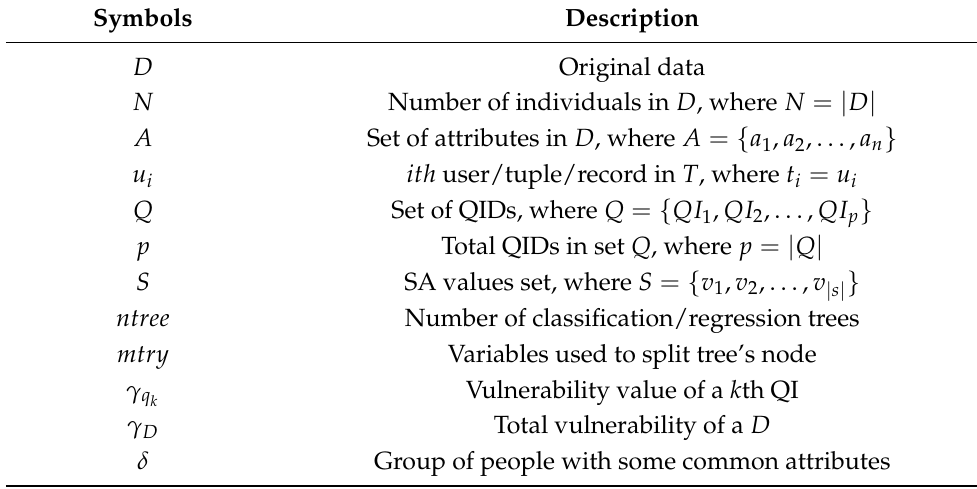
Table 3. Taxonomy of notations used in the proposed method.